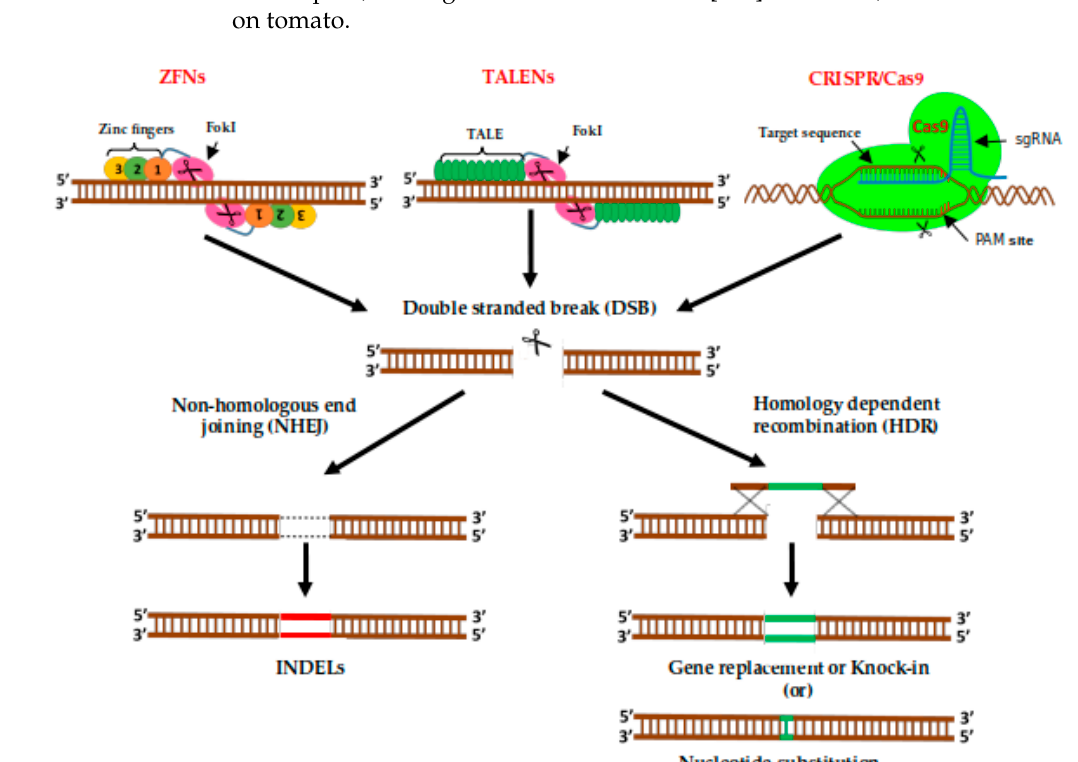
Figure 4. Represents the genome editing process in Zinc finger nucleases (ZFNs), transcription activator-like effector nucleases (TALENs) and CRISPR/Cas9. A pair of ZFNs bound to DNA. ZFNs are synthetic proteins with separate DNA-cleavage and DNA-binding domains, connected by a short linker sequence. By designing the recognition domain, it is possible to control the site of cleavage. The DNA-binding domain consists commonly of three ZFs. Each connects with 3 bp of target DNA. TALENs consist of a programmable DNA-binding domain and an unspecific Fok I cleavage domain. The TALENs recognition domain consists of two TALE DNA-binding sites, which contain arrays of multiple 34-amino acid repeat sequences. A single DNA nucleotide can be recognized by the amino acids at the 12th and 13th position. Or the CRISPR/Cas9 system, the first 20 bp guide sequence can quickly design and fused to the scaffold (gRNA backbone) sequence immediately upstream of a protospacer adjacent motif (PAM). The designed gRNA makes it possible to precisely guide the Cas9 RNA-guided endonucleases (RGENs) to induce a double-stranded DNA break (DSB) in the gene of interest. DBS in the target DNA is repaired either by NHEJ method resulting in small insertions or deletions (INDELs), or by HDR leading to knock-in or nucleotide